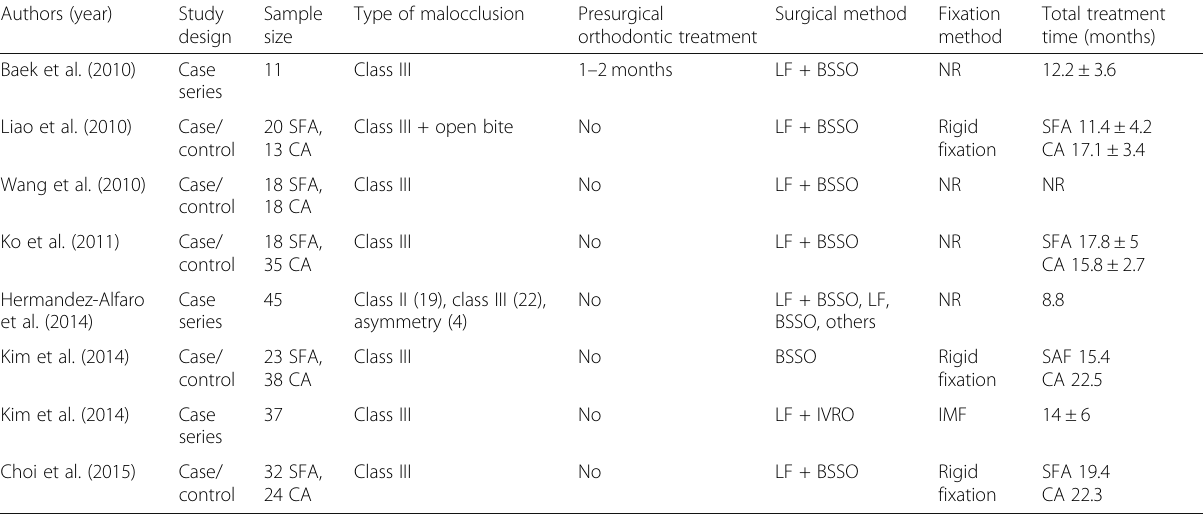
Table 1 Literature overview of orthognathic surgery using the surgery-first approach Authors